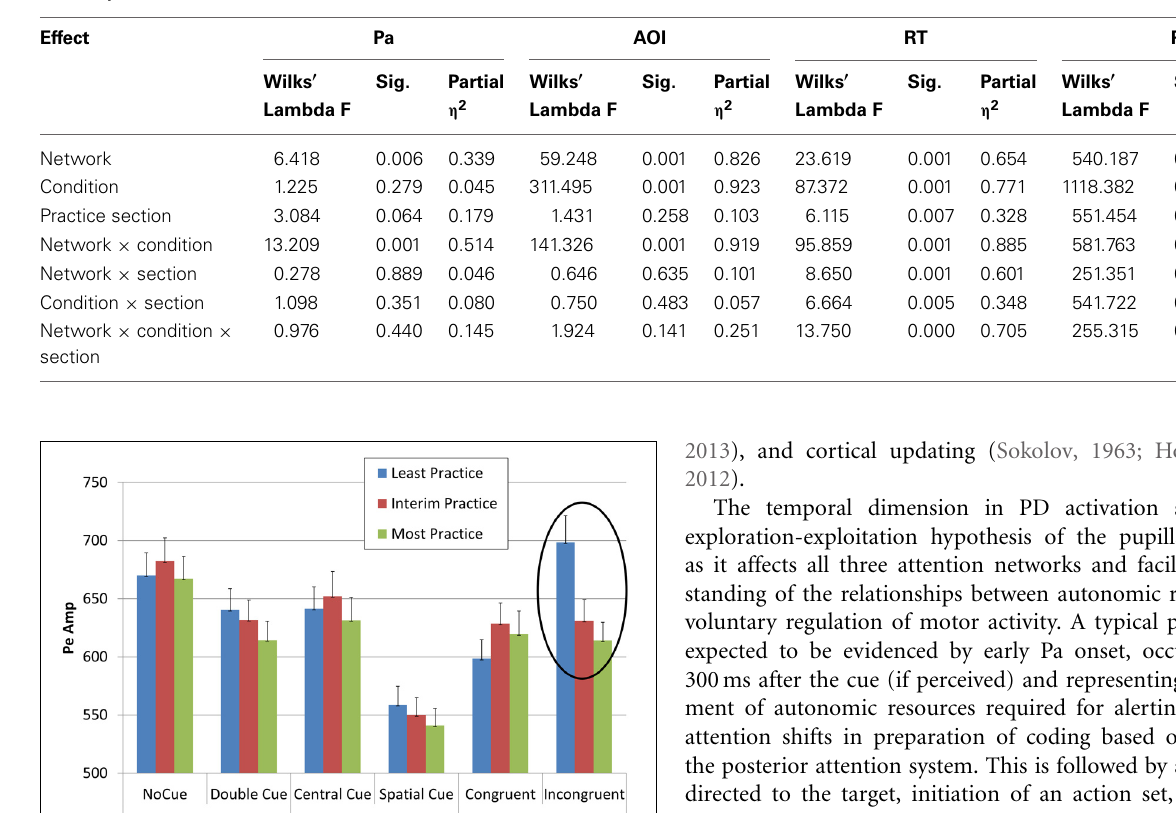
Table 2 | Repeated measures analyses of pupillary and behavioral measures as a function of network, condition, and section.